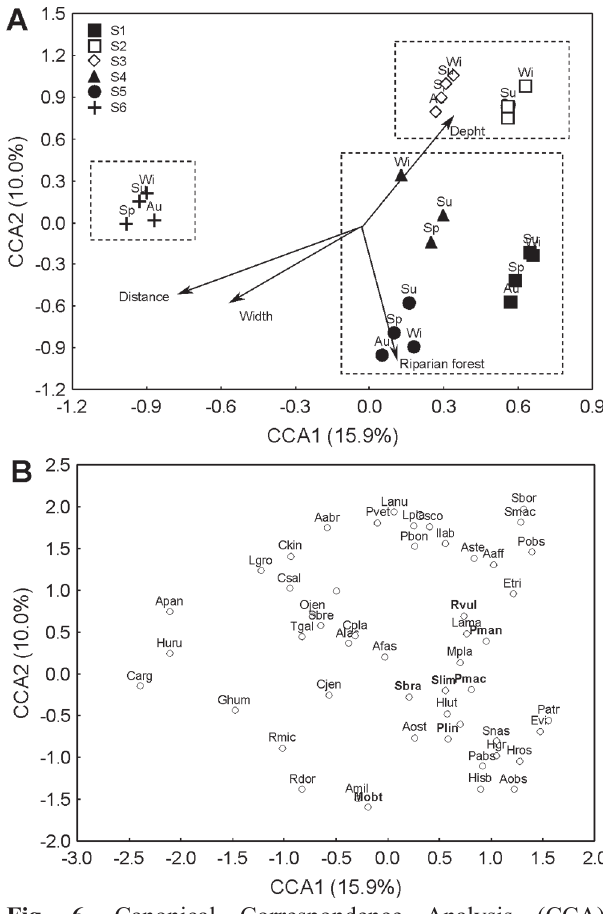
Fig. 6. Canonical Correspondence Analysis (CCA) applied to investigate the association between fish assemblage structure and environmental variables (spatial, geomorphology and landscape) along the Middle Uruguay River (A), and the influence of species on the ordination (B). Seasons: Au= Autumn; Sp = Spring; Su= Summer and Wi= Winter. Migratory species are marked in